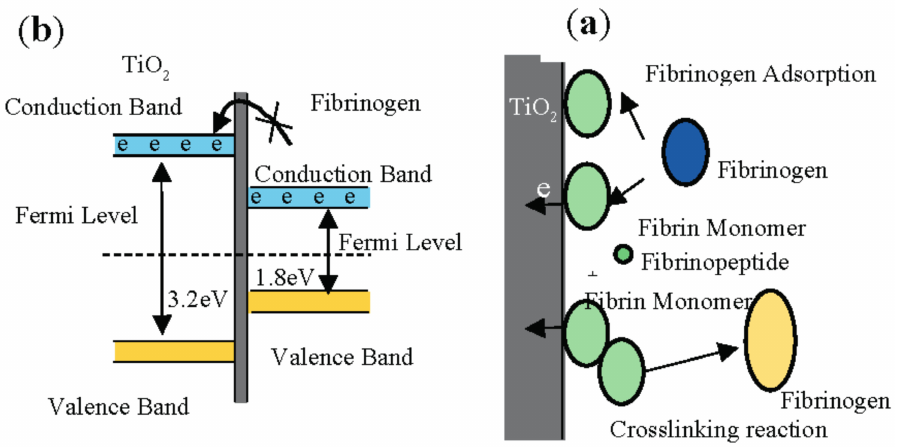
Figure 13. Schematic diagram for electrochemical action of TiO 2 and fibrinogen after adsorption: ( a ) electrochemical process; and ( b ) energy band diagram